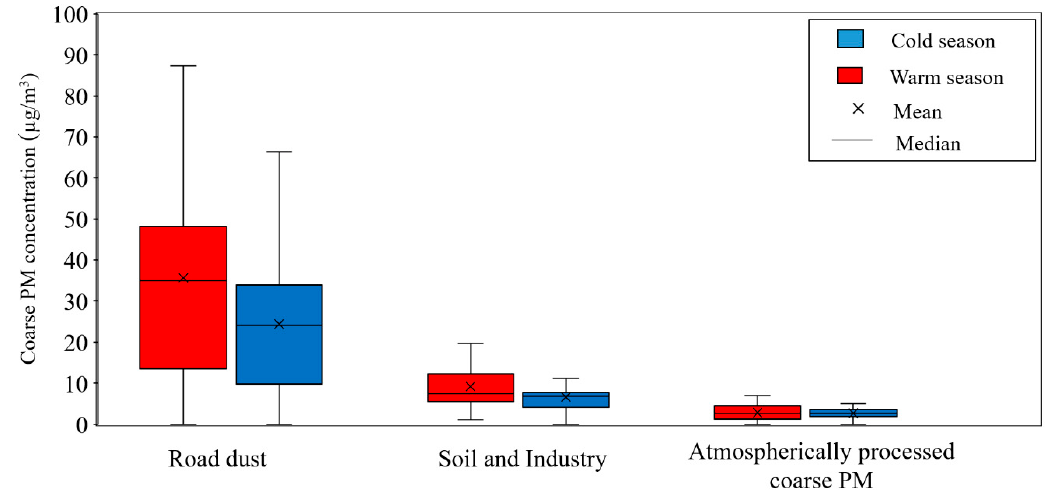
Figure 7. Seasonal concentrations of resolved factors to total coarse PM. The boxes indicate inter-quartile range (25th to 75th percentile) while whiskers represent the 5th and 95th percentiles.